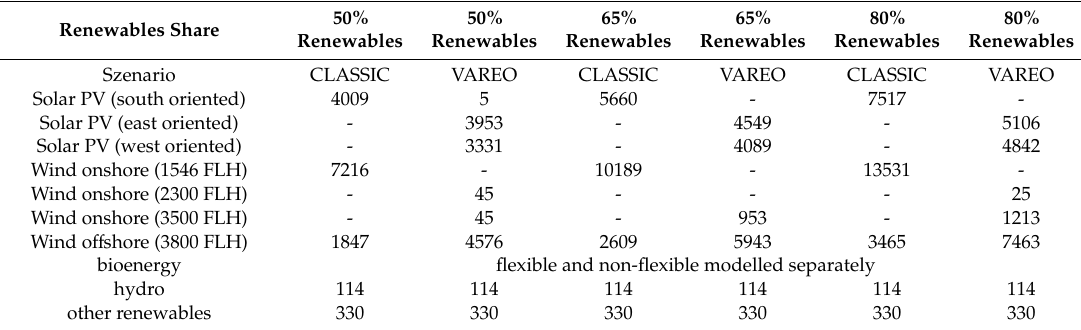
Table A2. Installed renewable capacities for the investigated wind-dominated region. Renewables